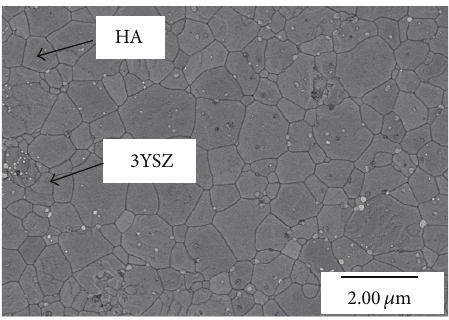
Figure 6: FESEM image of HA/0.5 wt% 3YSZ with conventional sintering.